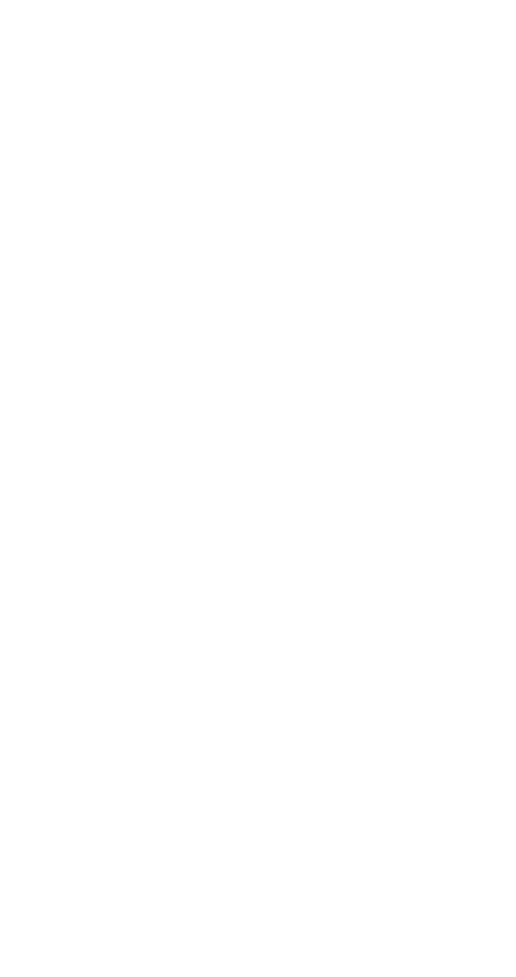
Figure 4. Traditional algorithm for three-phase flash calculations. Adapted with permission from Ref. [23]. 2006, Saeid Mokhatab, William A. Poe, James G. Speight.